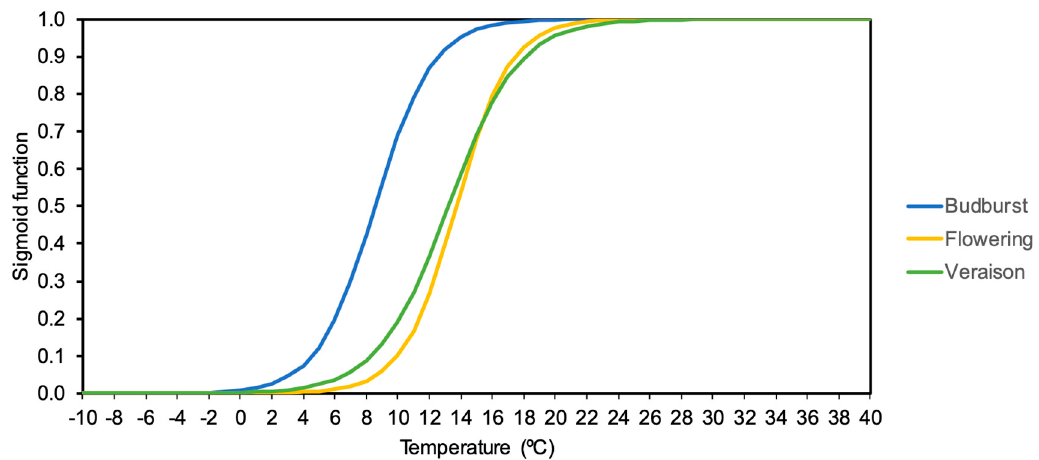
Figure 5. Representation of the generalized sigmoid models (GSM) for each phenological stage: 350 budburst (blue), flowering (yellow), and veraison (green). 351